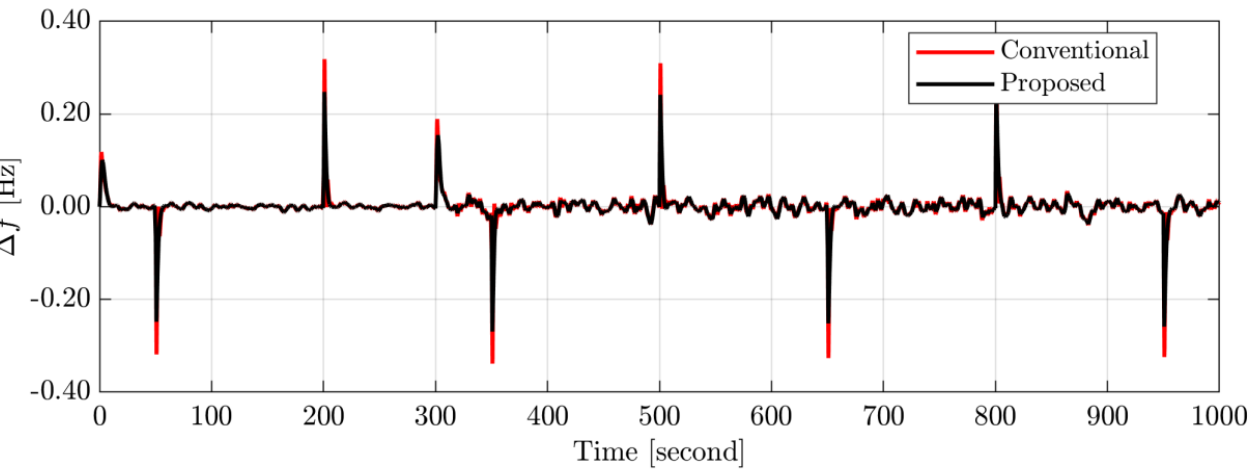
Figure 18. System frequency deviation of the studied µG for the case 4.